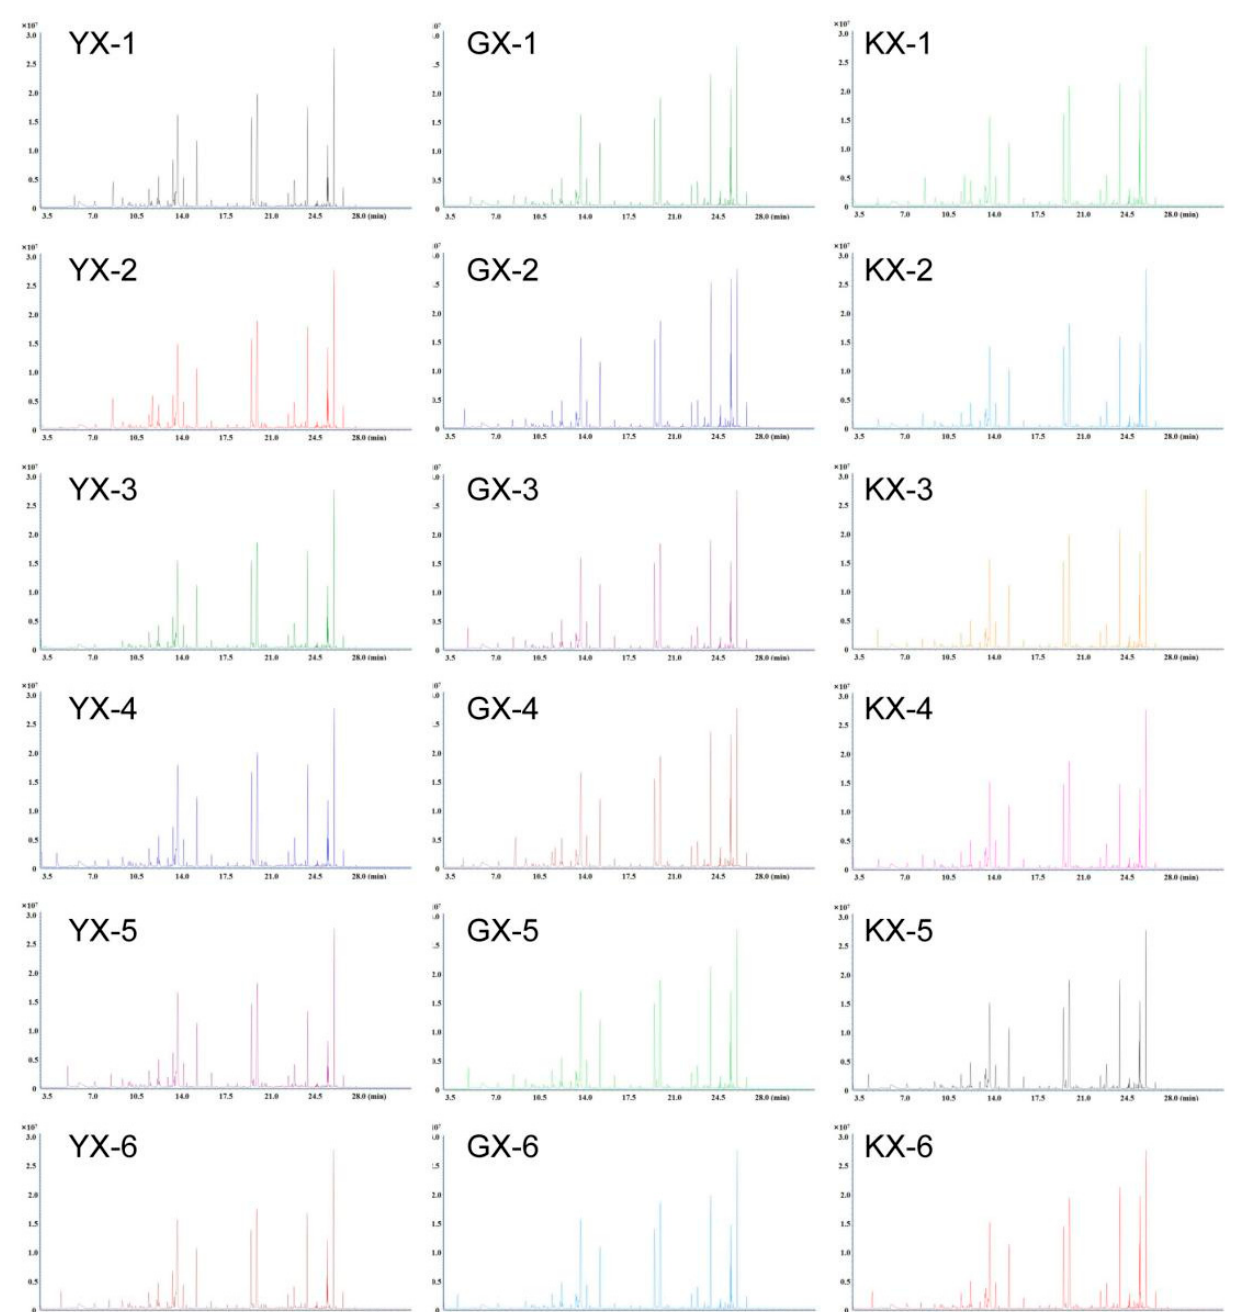
Figure 2. Total ion current chromatograms of volatile compounds in cucumber fruit. The abscissa is the retention time (Rt) of metabolite detection, and the ordinate is the ion flow intensity of ion detection (intensity unit: CPS, count per second).